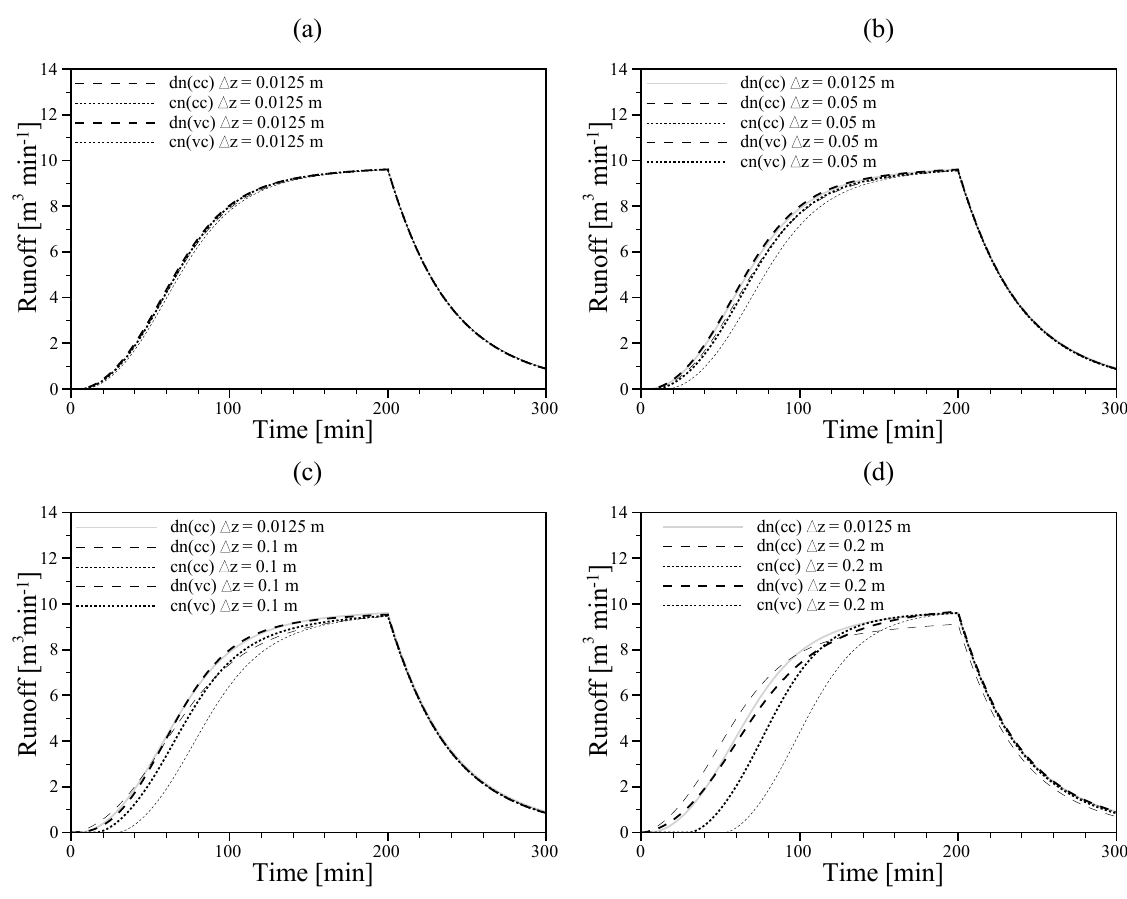
Figure 6. Outflow response for excess infiltration on a hillslope (second scenario) using different vertical